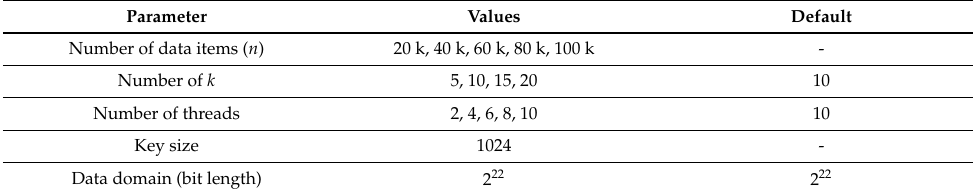
Table 3. Parameters for performance evaluation in multi-core